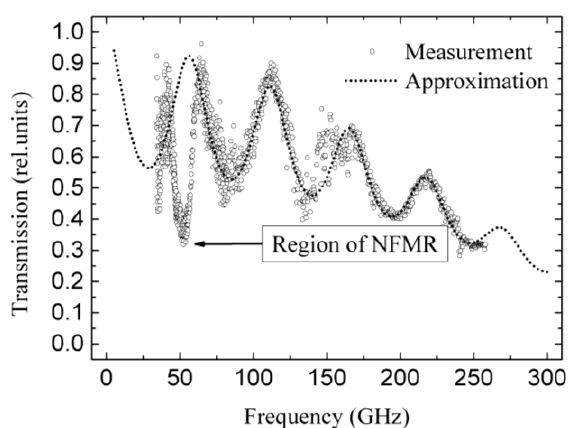
Fig. 3. Frequency dependence of the transmission coefficient of composite based on 60 wt.% BaFe 12 O 19 ferrite and epoxy resin